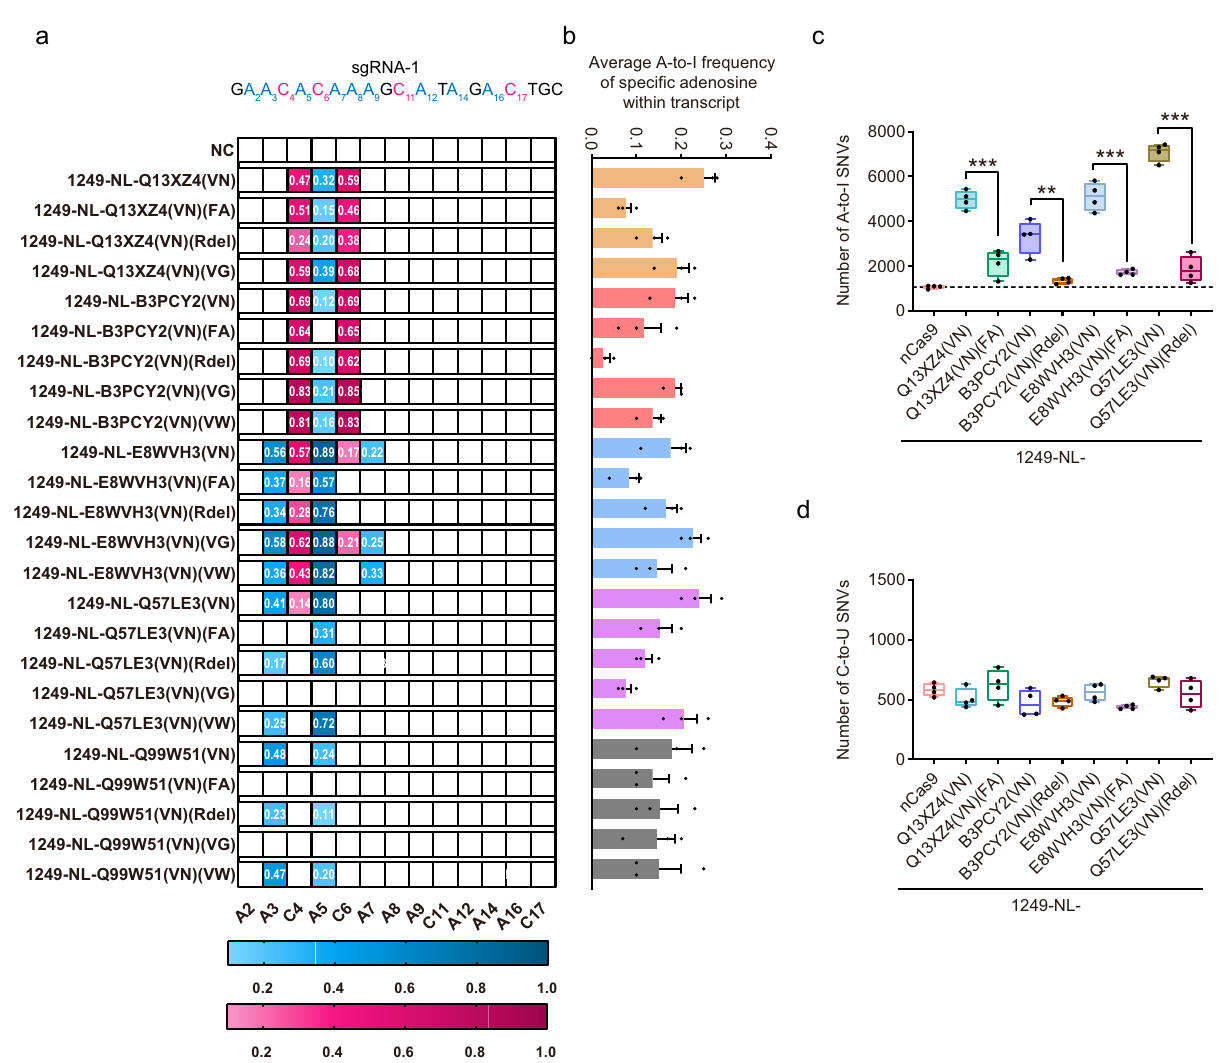
shown here represent means of results from n =3 biologically independent experiments.Datawerepresentedasmeanvalues±SEM. c , d Boxplotsshowingthe number of RNA A-to-I ( c ) and C-to-U edits ( d ) induced by engineered TadA ortholog-derived base editors or nCas9 control. Box plots here are de fi ned by whiskersintermsofminimaandmaxima,andthecenterandboundsoftheboxby quartiles (Q1 – Q3). n =4 biologically independent experiments. ** represents P <0.01 and *** represents P <0.001 with two-tailed unpaired t -test. Exact P values were as follows, P =0.000241, 0.002087, 4.24e-05, and 6.33e-06,